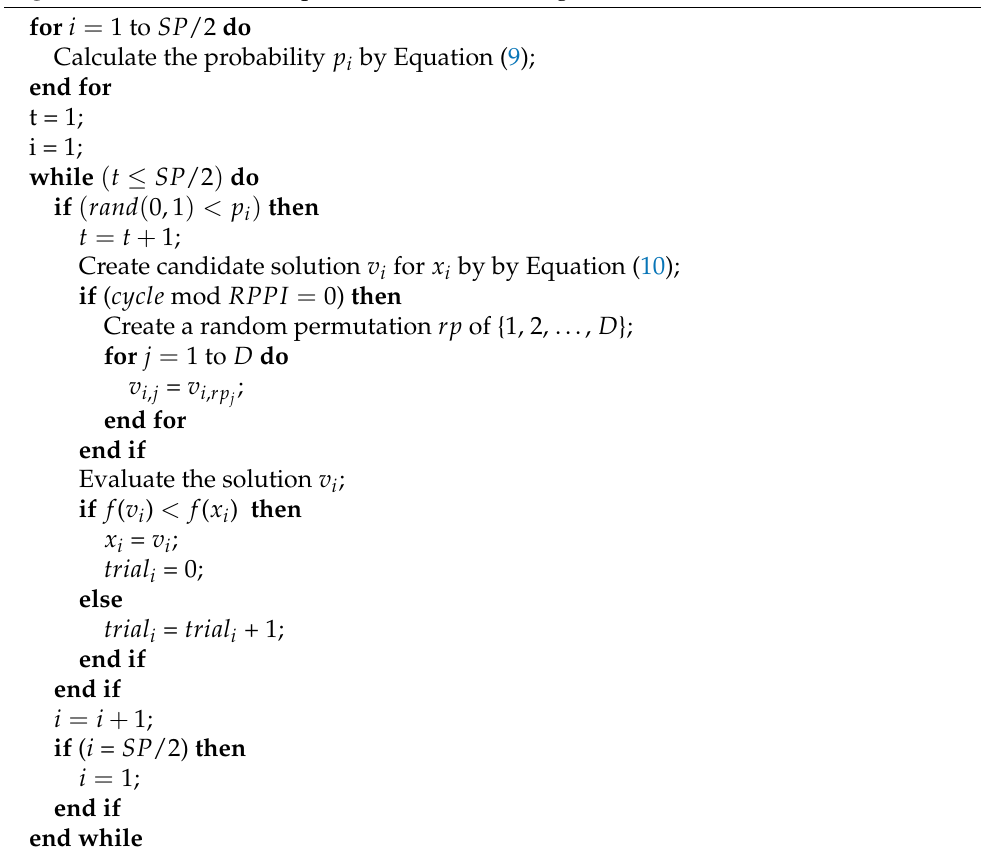
Algorithm 2 Onlooker bee phase of the SB-ABC algorithm